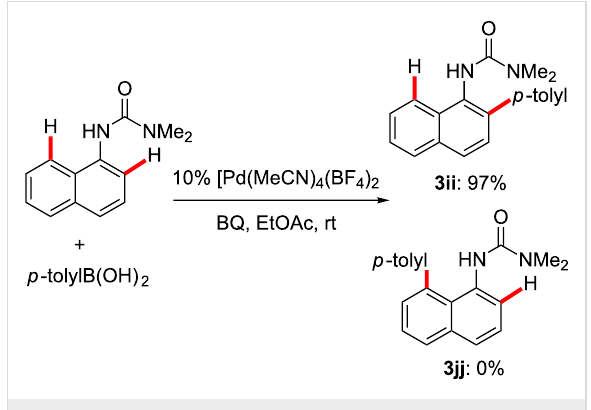
Scheme 5: Selective arylation of a 1-naphthylurea